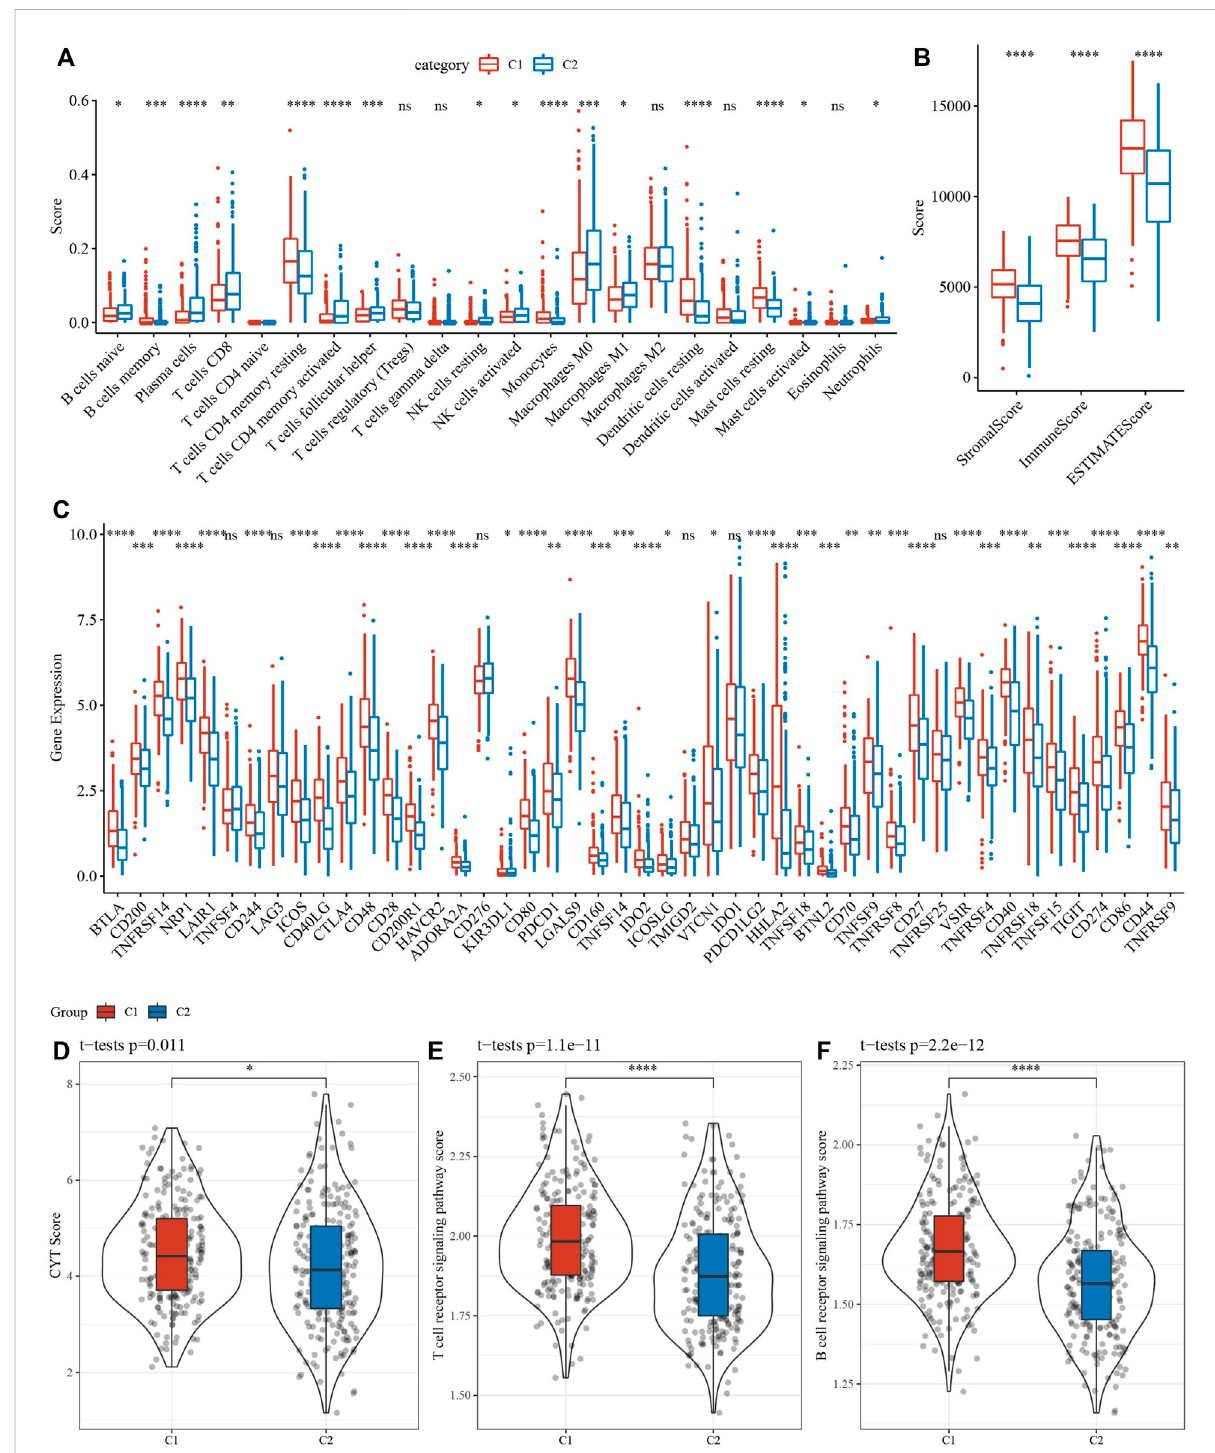
FIGURE 6 Analysis of immune in fi ltration. (A) analysis of 22 immune cells using CIBERSORT. (B) Analysis of immune in fi ltration using ESTIMATE. (C) The expression levelsof42immunecheck genesbetweenC1and C2. (D – F) The differences ofCTY score, Tcell receptor signaling pathwayscore,B cell receptor signaling pathway score between C1 and C2. * p < 0.05, ** p < 0.01, *** p < 0.001, *** p < 0.0001, ns: no signi fi